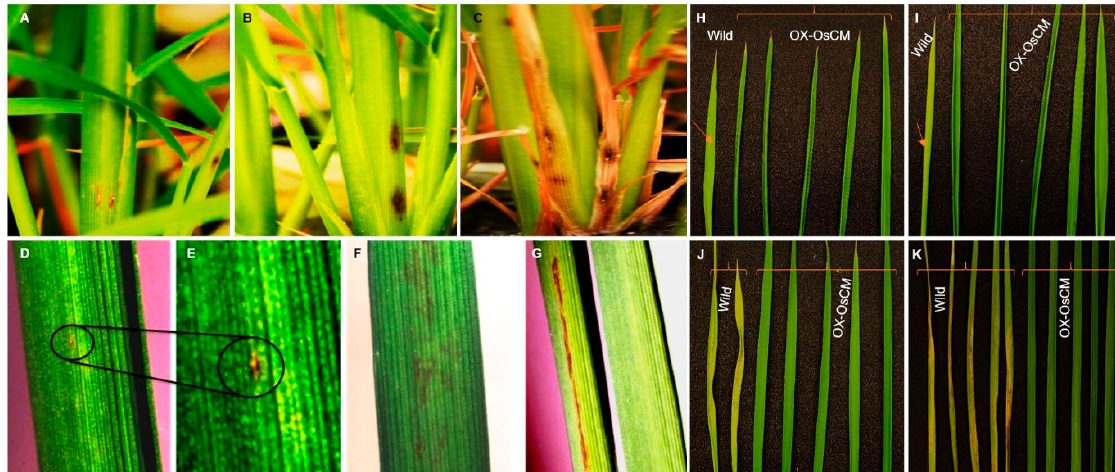
Figure 4. Phenotypic evaluation of transgenic and wild type rice under WBPH stress. Panel ( A ) represents OX- OsCM , a minor symptom that appeared after 30 days of infestation. ( B , C ) Cheongcheong and infection appeared very early, but the pictures taken after 20 days and 30 days, respectively, indicate that the infection increased very rapidly and finally the leaves died. ( D , E ) The spreading rate of infection in OX- OsCM leaf indicated with circles. ( F , G ) The pattern of spreading symptoms in Cheongcheong leaves. ( H – K ) The infection spreading rate after each time point and wild and OX- OsCM leaves differentiated with braces. Arrows in panels (H,I) indicate the initial infection site in Cheongcheong. Wild; Cheong- cheong.